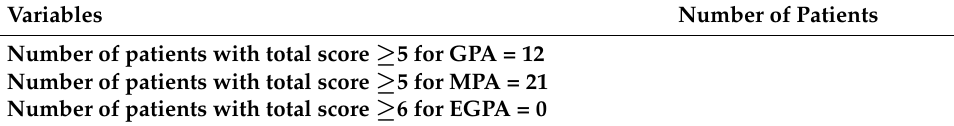
Table 2. Cont. Variables Number of Patients Number of patients with total score ≥ 5 for GPA = 12 Number of patients with total score ≥ 5 for MPA = 21 Number of patients with total score ≥ 6 for EGPA = 0 Values are expressed as number (percentage). ACR: American College of Rheumatology; EULAR: European Alliance of Associations for Rheumatology; GPA: granulomatosis with polyangiitis; MPA: microscopic polyangiitis; EGPA: eosinophilic granulomatosis with polyangiitis; SARS-CoV2: severe acute respiratory syndrome coronavirus 2; ANCA: Antineutrophil cytoplasmic antibody; PR3: proteinase 3; MPO: myeloperoxidase; ILD: interstitial lung disease.